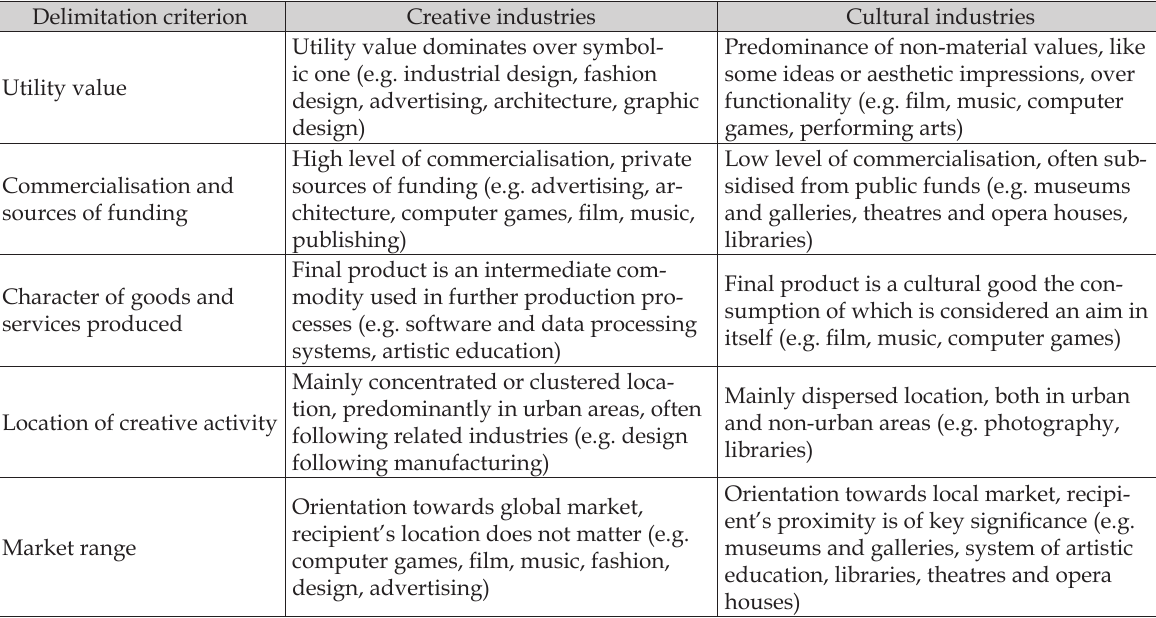
Table 1. Selected criteria for the delimitation of creative and cultural